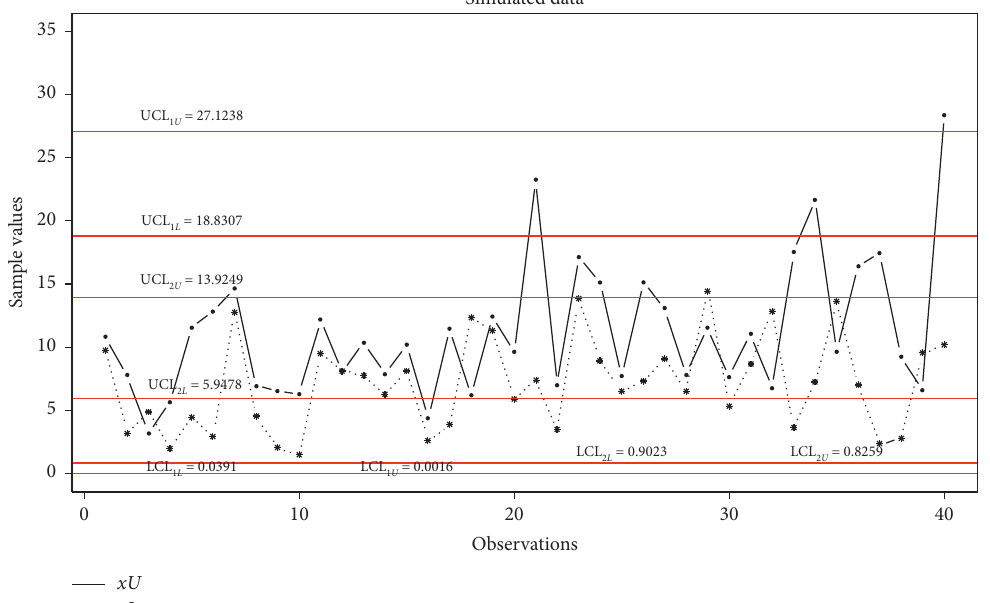
[ 3 , 5 ] , b [ 1 . 9 , 2 . 1 ] , n [ 20 , 20 ] ,k ∈ [ 4 . 5948 , 5 . 2333 ] , and k ∈ N ∈ N ∈ N ∈ 1 N 2 N